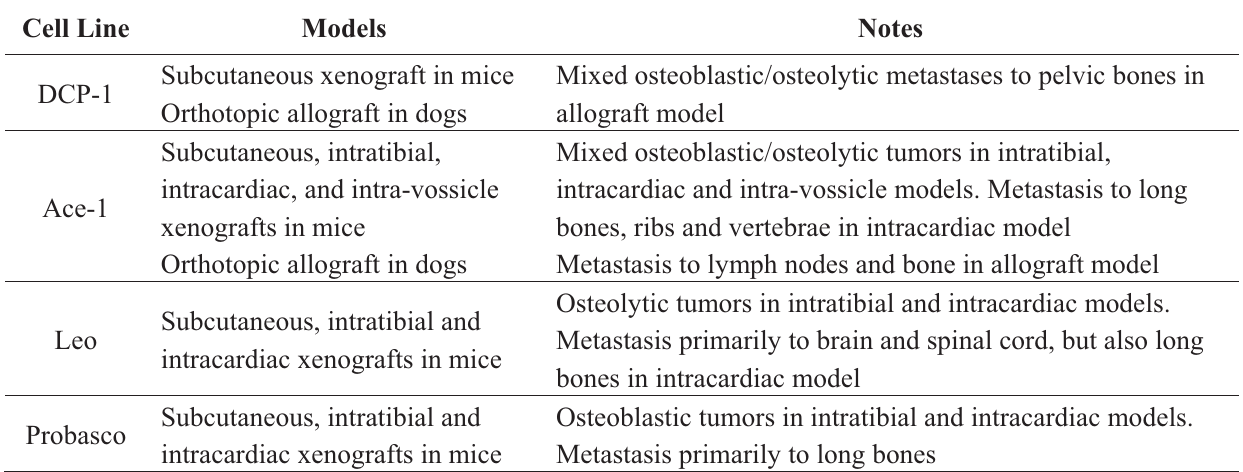
Table 1. Canine Cell Lines that Metastasize to